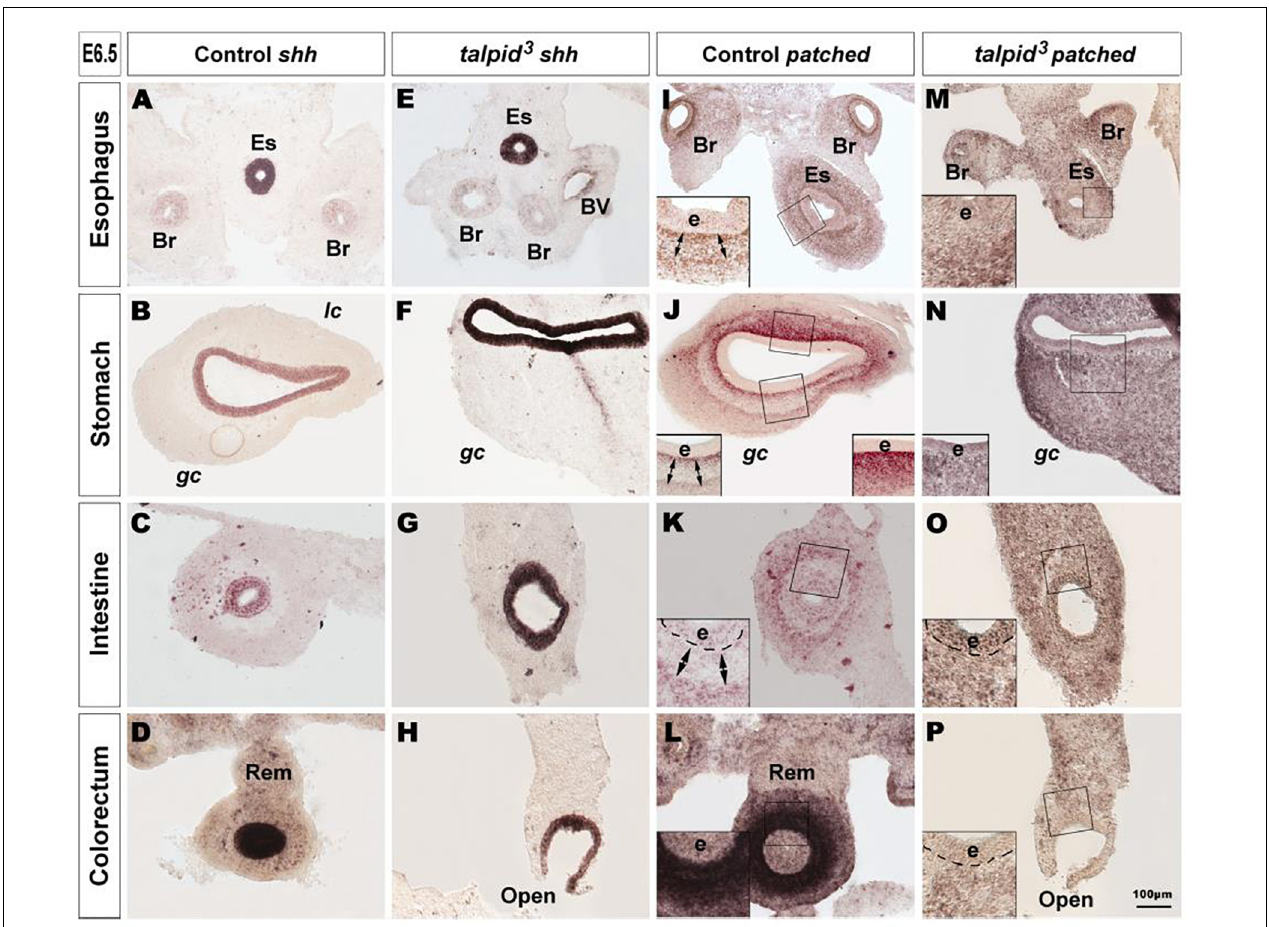
FIGURE 2 | Hh signaling is disrupted in the GI tract of talpid 3 mutants. (A–P) In situ hybridization for shh (A–H) and patched (I–P) in E6.5 control (A–D,I–L) and E6.5 talpid 3 mutant (E–H , M–P) transverse sections. (A–H) In both controls and talpid 3 , shh is expressed in the endoderm in all gut regions. (I–L) Patched in situ in controls shows a discrete pattern of expression with one ( J–L + insets) or two ( I–K + Insets) concentric gradients. ( M–P + insets) In talpid 3 sections the patched gradient is replaced by uniform levels of expression. Es, esophagus; Br, bronchus; Rem, nerve of Remak; e, endoderm; lc , lesser curvature; gc , greater curvature of the stomach. Same scale bar in (A–P)